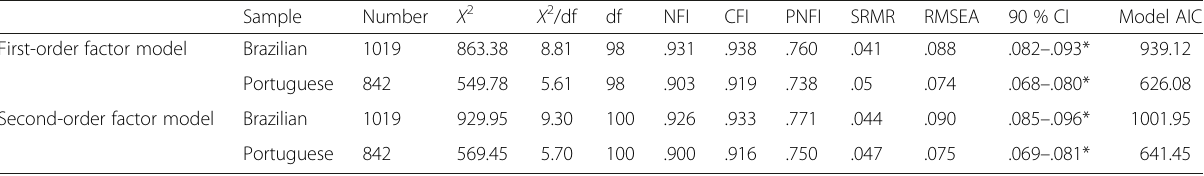
Table 2 Fit statistics of the hypothesized models for Brazil and Portugal